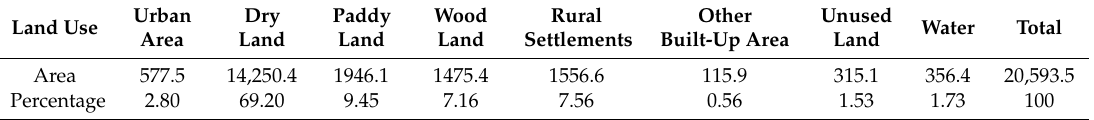
Table 2. Area (km 2 ) and percentage (%) of di ff erent land use types for the study area.